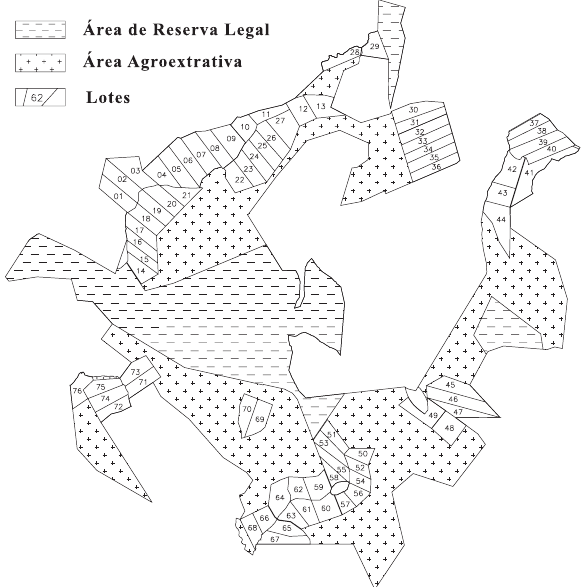
Figura 4. Distribuição das áreas dos Lotes familiares, Reserva Legal e Agroextrativista do Projeto de Assentamento